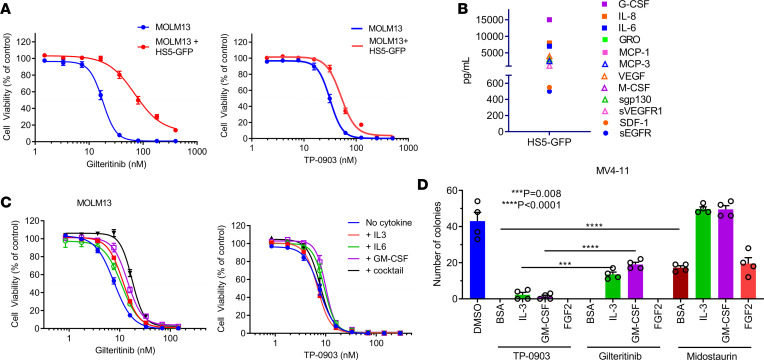
TP-0903 overcomes drug resistance due to bone marrow microenvironment–mediated factors.(A) Inhibition of MOLM13 cell viability ± coculture with HS5-GFP MSCs (MTT assay, 72 hours, n = 24). (B) Cytokine/chemokines/growth factors secreted by HS5-GFP cells (Luminex multiplex assay, n = 2). (C and D) Growth inhibition of MOLM13 (MTT assay, 72 hours, n = 12) (C) or 7-day MV4-11 CFU assay (n = 4) (D) treated with indicated TKI ± cytokine/chemokine/growth factor support. P values were determined using 1-way ANOVA (P < 0.0001) with Tukey multiple comparison test, with specific P values indicated within the figure.